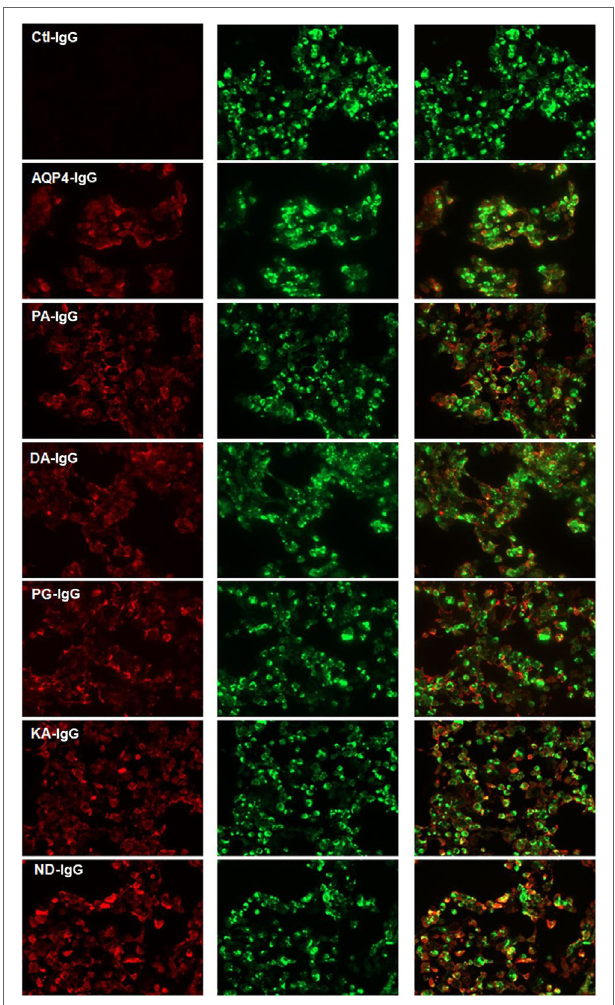
FigUre 1 | Cell-based assay demonstrating binding of AQP4–IgG and Fc-mutated AQP4–IgG to AQP4 transfected cells. Binding of infrared labeled AQP4–IgG and all Fc-mutated antibodies DA-IgG, KA-IgG, PA-IgG, and PG-IgG (shown in red) to HEK cells which express AQP4 fused with a green fluorescent protein (shown in green). The mutations do not interfere with the ability of the antibodies to bind AQP4. The isotype Ctl-IgG, does not bind to AQP4 transfected cells. None of the antibodies bind to non transfected cells (not